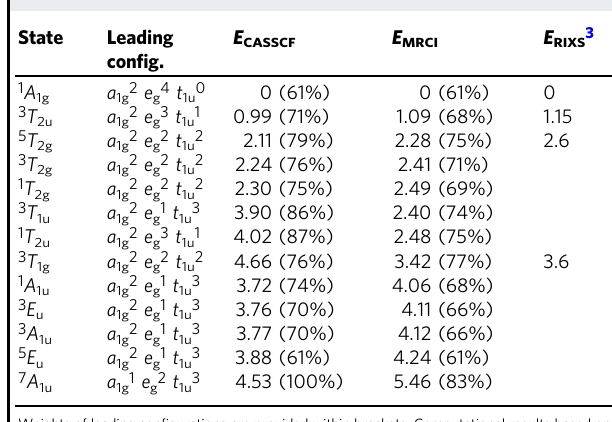
Weights of leading con fi gurations are provided within brackets. Computational results based on complete active space self-consistent fi eld (CASSCF) and more sophisticated multi-reference con fi guration interaction (MRCI) are given in comparison to experimental resonant inelastic x-ray scattering (RIXS)